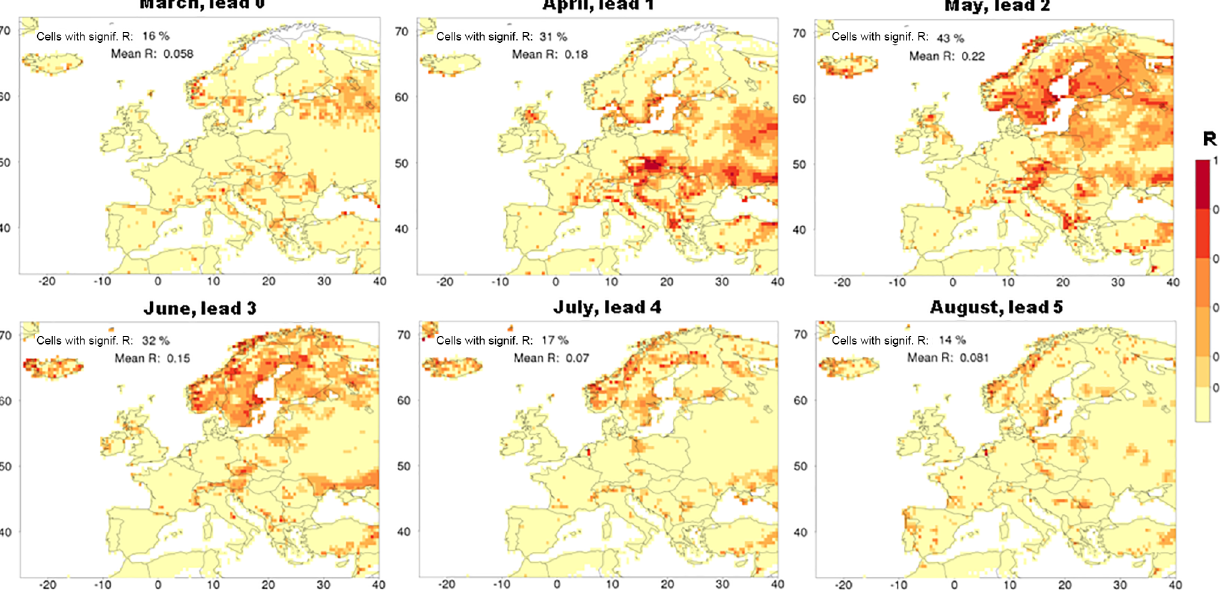
Figure 7. Example showing the variation of skill in run-off as a function of lead time in the SnInitSHs, for initialisation on 1 March. For more explanation, see Figs. 1a and